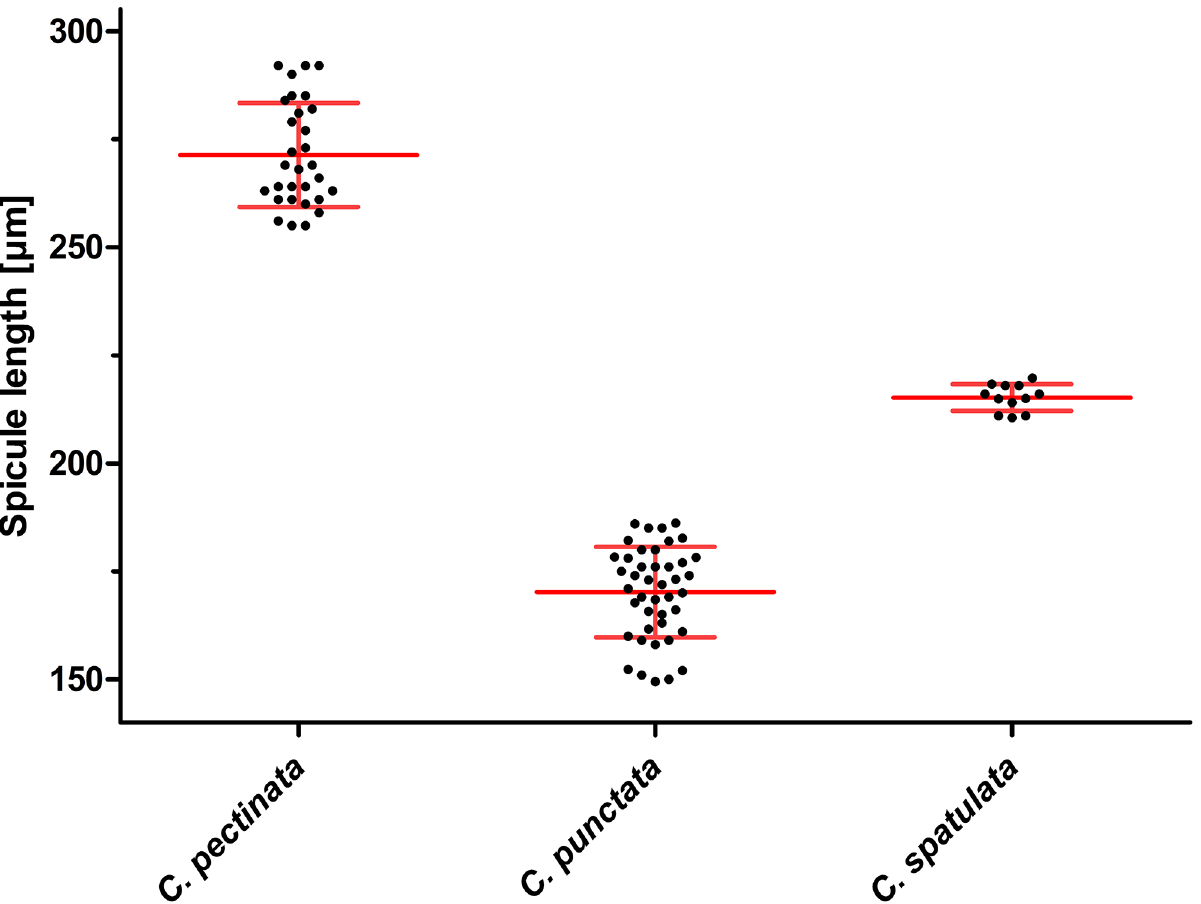
Fig 2. Scatter plot of spicule length of Cooperiapectinata , Cooperiapunctata and Cooperiaspatulata collected from a calf in Brazil. Mean spicule length of 30 C . pectinata , 43 C . punctata and 12 C . spatulata was plotted and compared using One-Way-ANOVA and Bonferroni post-hoc tests. All groups were significantly different with p < 0.0001 but it must be kept in mind that the C . punctata worms were preselected according to a smaller over- all length which clearly introduces a systematical bias. Individual values are shown in black while mean ± SD are indicated in red.